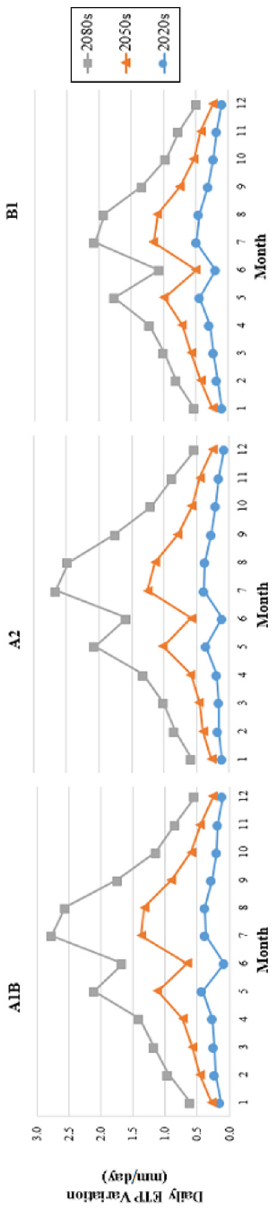
Figure 2. Daily ETP changes compared with the observed period in Kermanshah